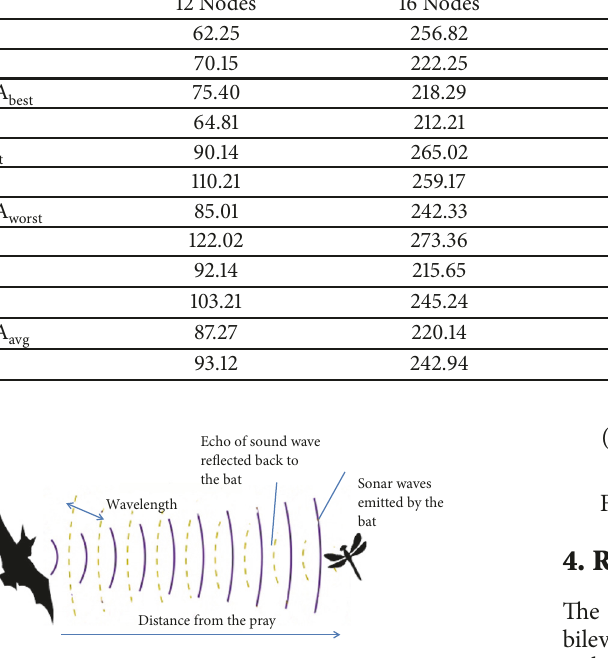
Figure 3: Echolocation behavior of the